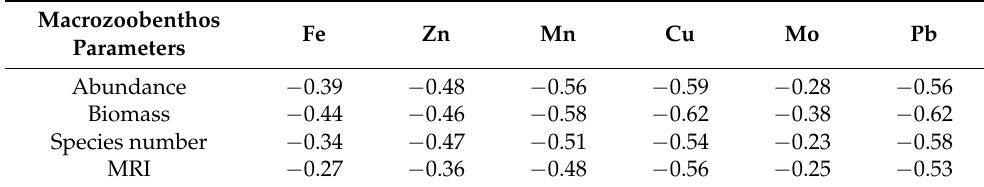
Table 9. Pearson’s coefficients of correlations between macrozoobenthos parameters (April) and HMs in macrozoobenthos.